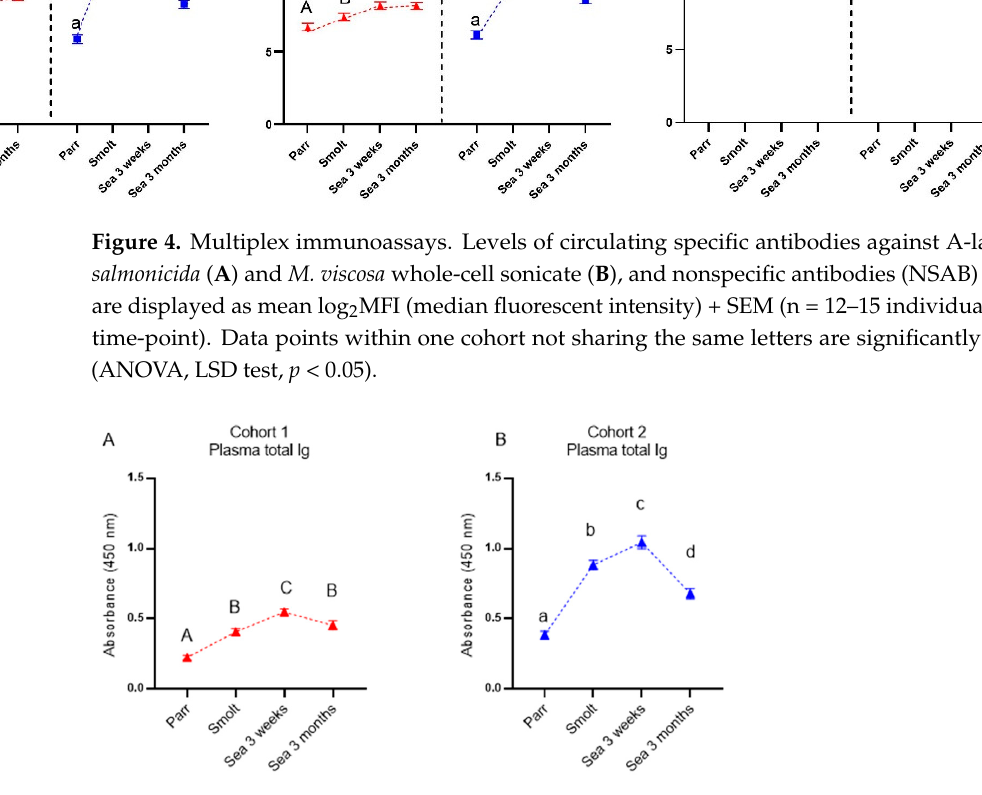
Figure 5. Total immunoglobulin (Ig) in plasma from Atlantic salmon from cohort 1 ( A ) and cohort 2 ( B ). Samples are analyzed by ELISA and at an absorbance of 450 nm. Data are presented as mean with SEM (n = 12–15 individuals at each time-point). Data points within one cohort not sharing the same letters are significantly different (ANOVA, LSD test, p < 0.05).